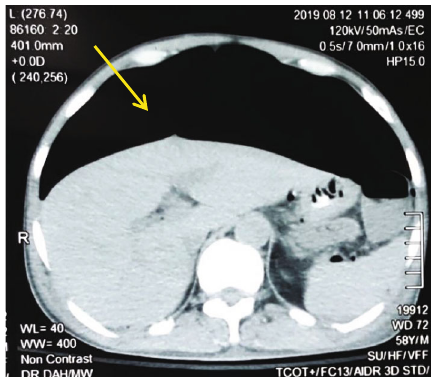
Figure 3: Noncontrast CT scan of the abdomen: yellow arrow shows the presence of intraperitoneal gas.